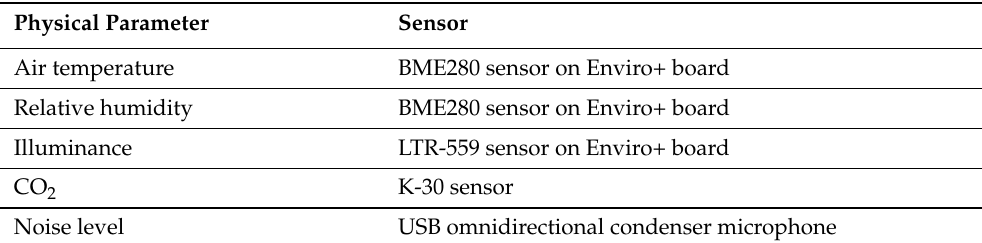
Table 2. Physical parameters and corresponding